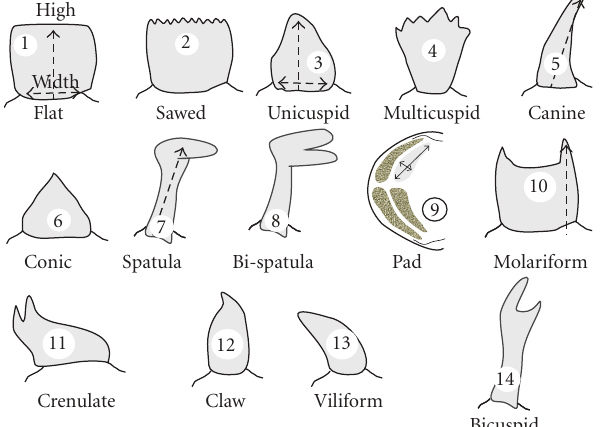
Figure 3: Diagram of di ff erent type of teeth coded in the